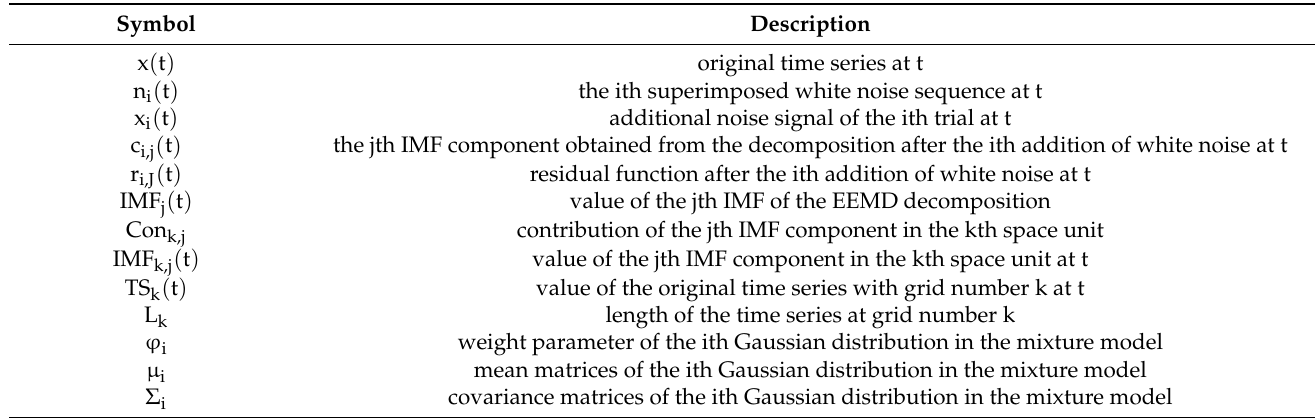
Table 1. Descriptions of mathematical